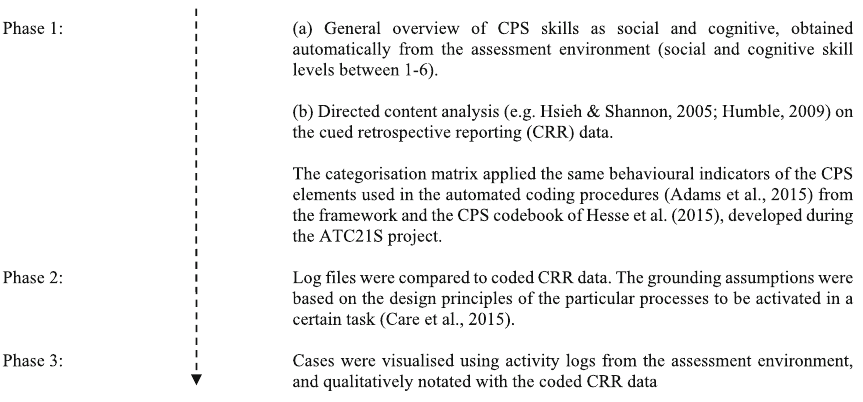
Fig. 4 An overview of the multiple phases of data analysis